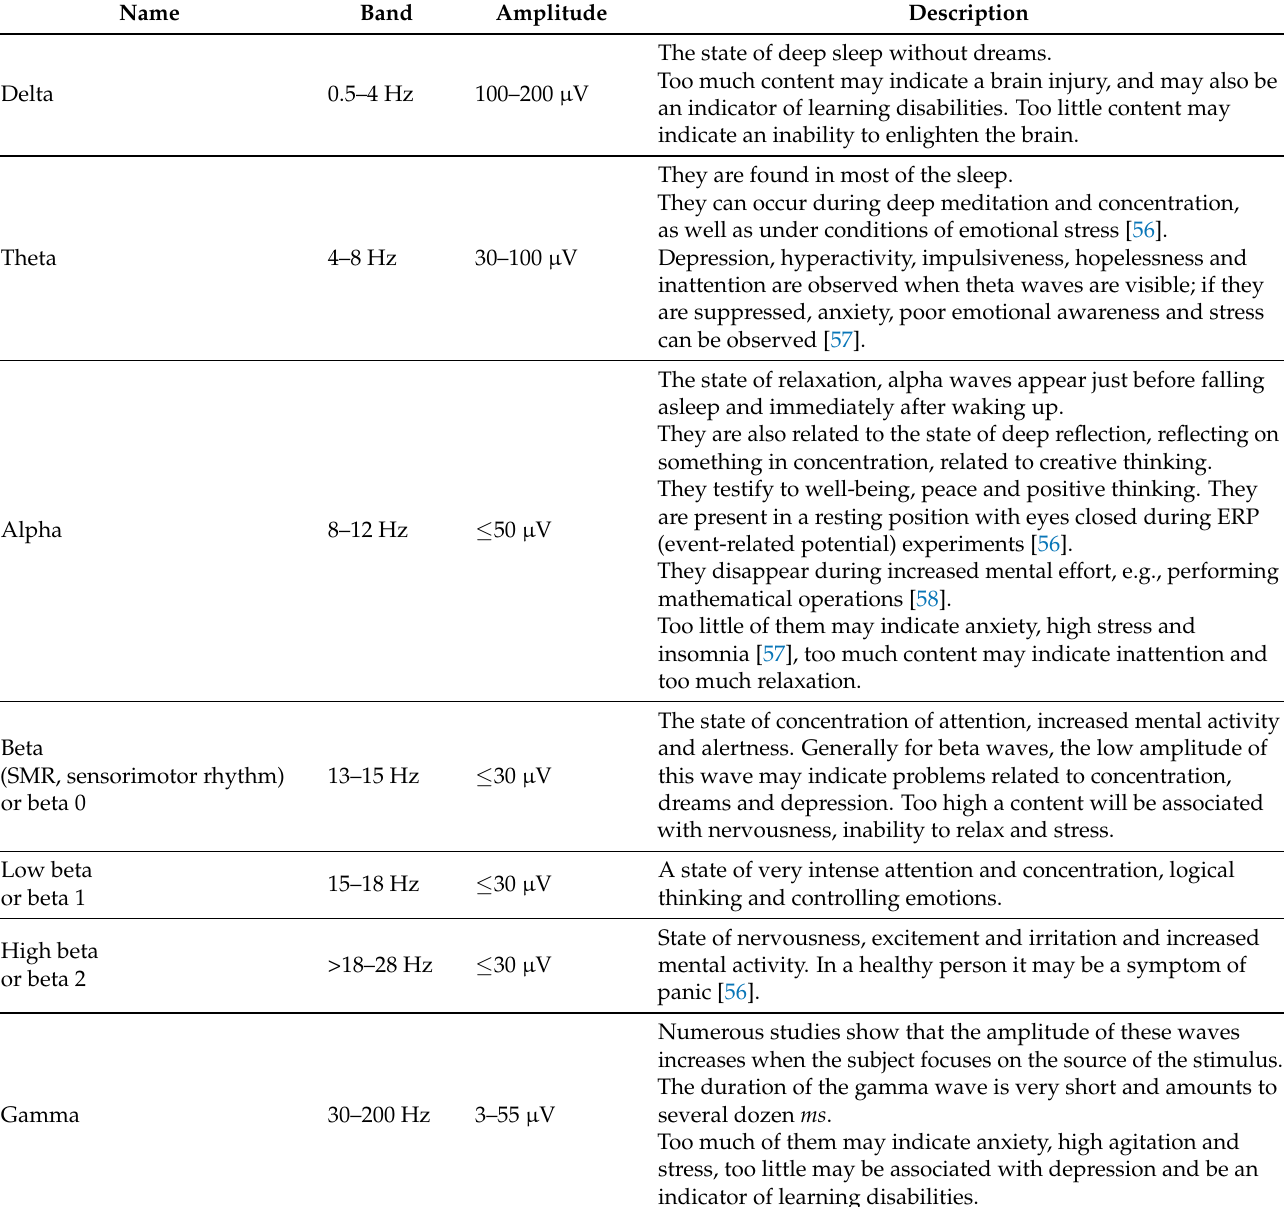
Table 2. Summary of brain wave activity